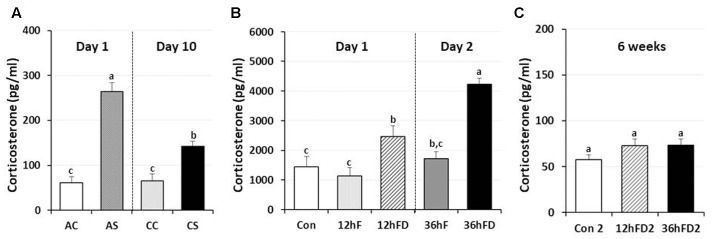
Differential response of plasma corticosterone (CORT) following acute, chronic immobilization stress (CS) or early-life nutritional stress in birds. (A) Attenuation of CORT response in chronic stressed birds compared to acute stressed birds by immobilization. Plasma CORT concentrations (pg/ml) were measured by radioimmunoassay (RIA) after acute or CS (n = 7–8 birds/group). (B) Plasma CORT concentrations were measured by RIA (n = 18 birds/group, duplicate). Treatments of 12 h (Day 1) or 36 h (Day 2) FD after post-hatching, blood was sampled from 0 h controls (Con), 12 h fed controls (12hF), 12 h FD (12hFD), 36 h fed controls (36hFD), and 36 h FD birds (n = 14birds/group). (C) At 6 weeks of age, blood was sampled from birds which were treated by 12hFD and 36hFD following post-hatching (Days 1 and 2). Plasma CORT concentrations were measured by RIA. Data (mean ± SEM) are presented as the fold changes of relative expression levels compared to the unstressed control group (Con) set at a value of 1.0. Different lower-case letters above the bars denote significant differences (P < 0.05) among groups, where a > b > c and b,c is not different from b or c.